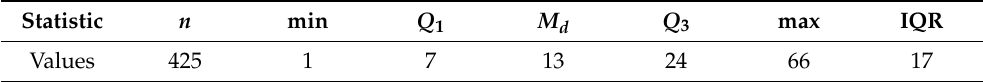
Table 11. Descriptive statistics for the COVID-19 data set of Belgium.